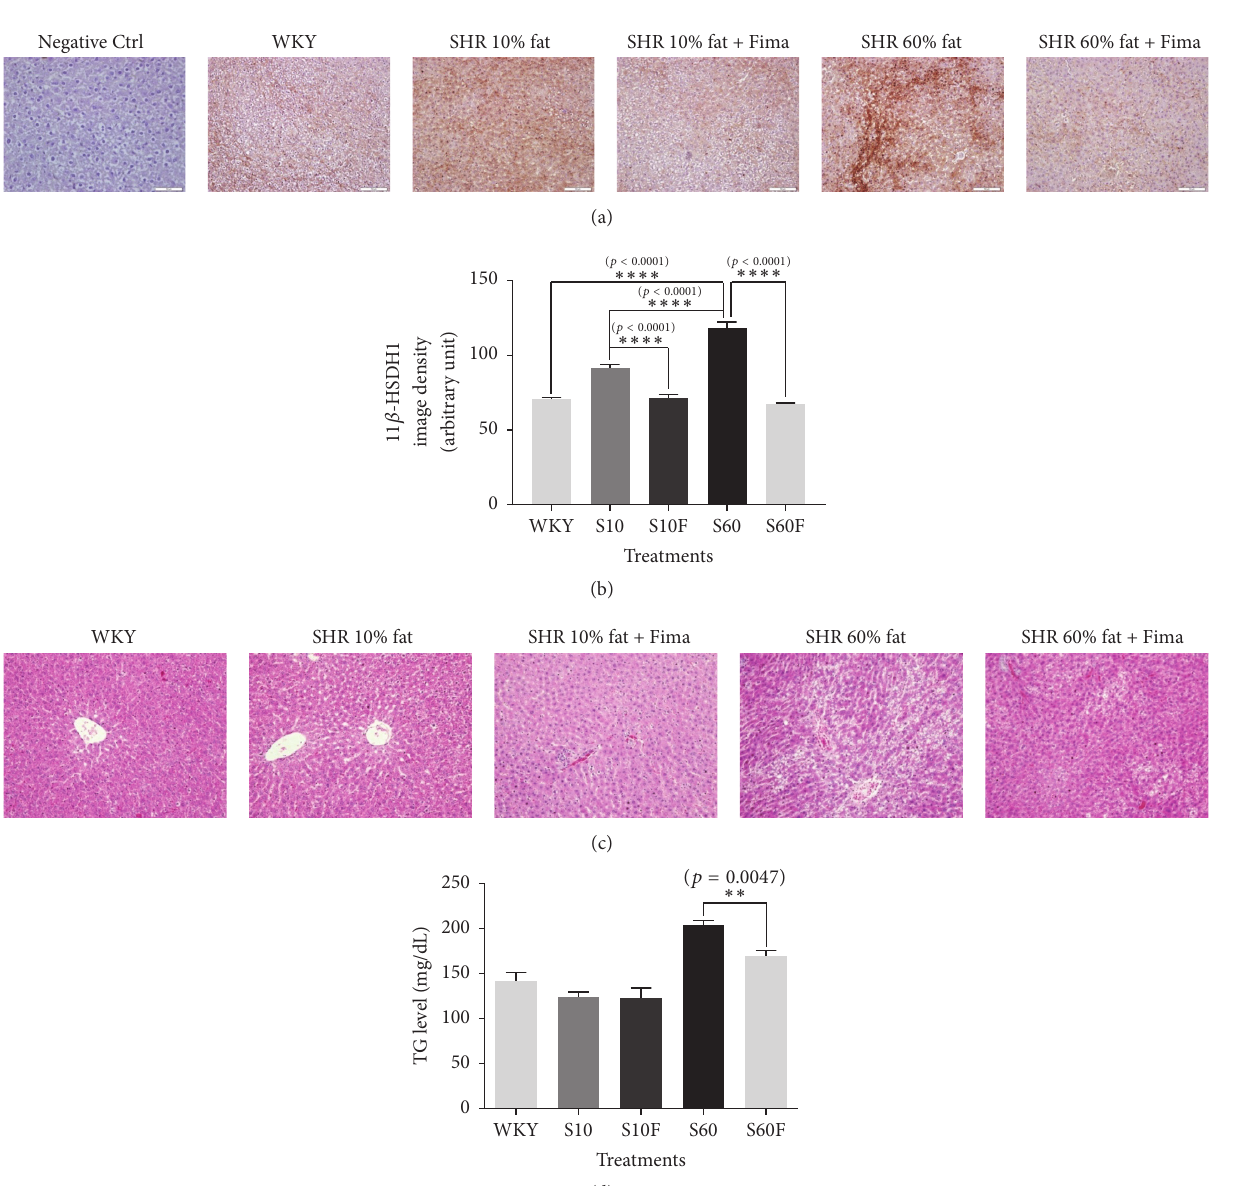
Figure 7: 11 beta-hydroxysteroid dehydrogenase type 1 (11 𝛽 -HSDH1) protein expression, hematoxylin and eosin staining, and the concentration of triglyceride in the liver tissue samples of WKY rats and SHRs given high-fat diet and fimasartan. (a) Liver tissue sections obtained from WKY rats and SHRs were fixed and stained by immunohistochemistry method for 11 𝛽 -HSDH1. Magnification is 100x. (b) The densities for images were analyzed with the ImageJ program. (c) Liver tissue sections obtained from WKY rats and SHRs were fixed and stained with hematoxylin and eosin reagents. Magnification is 200x. (d) Triglyceride contents in liver extracts obtained from WKY rats and SHRs were determined with triglyceride colorimetric assay kit. The results are expressed as means ± SEM ( 𝑛 = 3 or 6). Values were statistically analyzed by unpaired t -test. All experiments were repeated three times. Meaning of indications: WKY means normal control rat given normal diet containing 10% fat, S10 means SHRs given normal diet containing 10% fat, S10F means SHRs given normal diet containing 10% fat plus fimasartan, S60 means SHRs given high-fat diet containing 60% fat, and S60F means SHRs given high-fat diet containing 60% fat plus